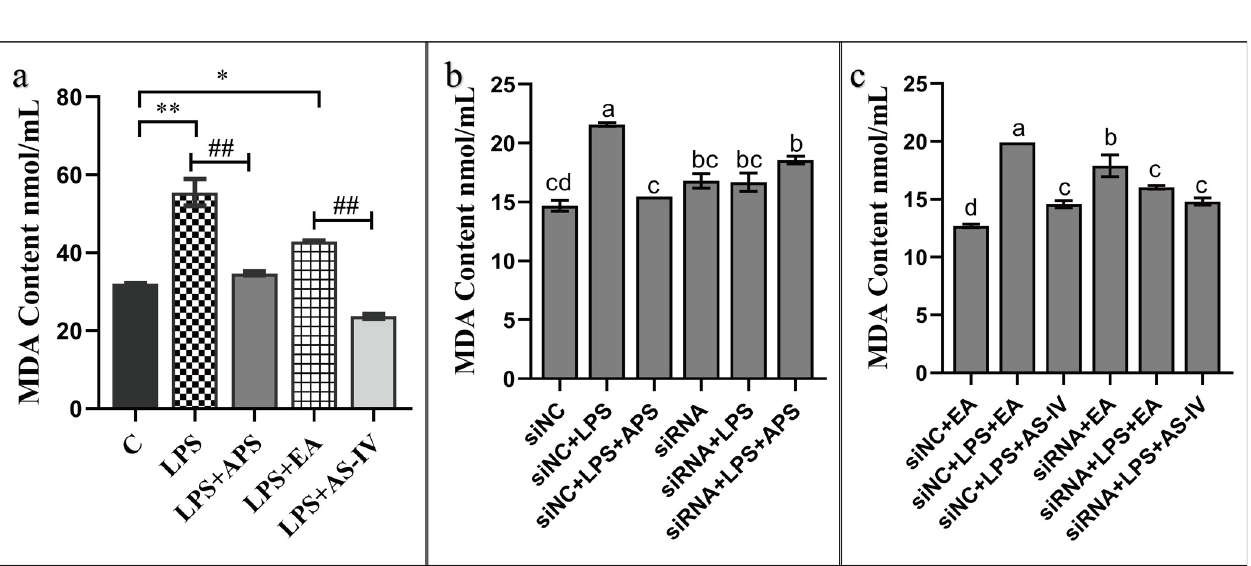
Fig 7. APS and AS-IV regulate the levels of MDA in BMECs under an inflammatory state. (a) APS and AS-IV inhibit the LPS-stimulated upregulation of MDA in LPS-stimulated BMECs. (b, c) Effect of APS and AS-IV on the levels of MDA in LPS-stimulated BMECs after silencing β -catenin. Each experimental group expresses the same meaning as in Fig 5. Data are expressed as the mean ± SD of 3 independent experiments. � , # represents 0.01 < P < 0.05, �� , ## represents P < 0.01, ns represents P > 0.05, and letter differences in the graphs indicate significant P < 0.05 differences between groups.